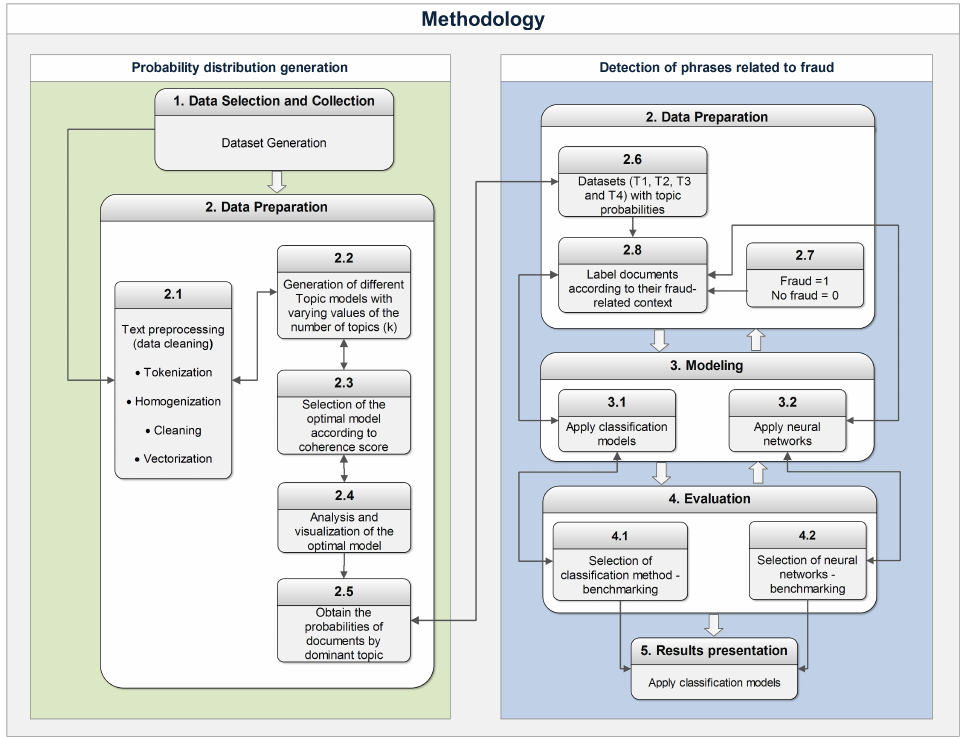
Figure 2. Methodology used to determine the existence of fraud.